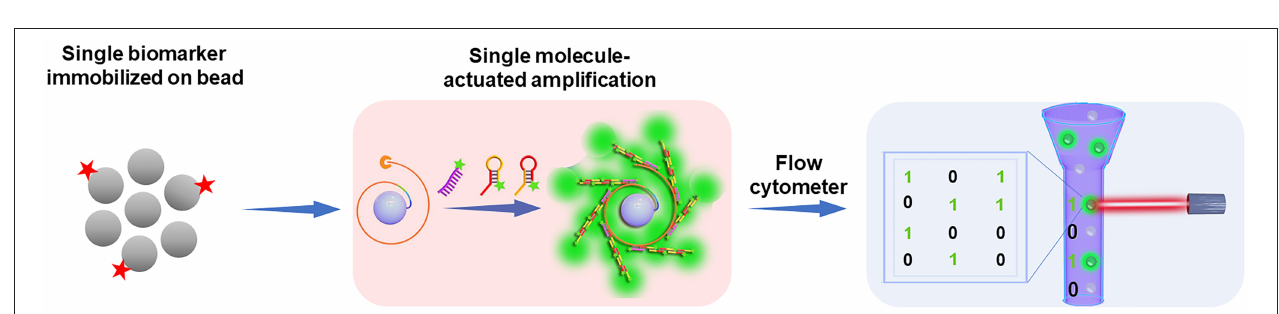
FIGURE 1 | Schematic illustration of 2-well-recognized digital bead counting bioassay technologies. Reproduced with permission from Dressman et al. (2003). Copyright 2003, National Academy of Sciences (BEAMing). Reproduced with permission from Rissin et al. (2010). Copyright 2010, Nature Publishing Group (Simoa).